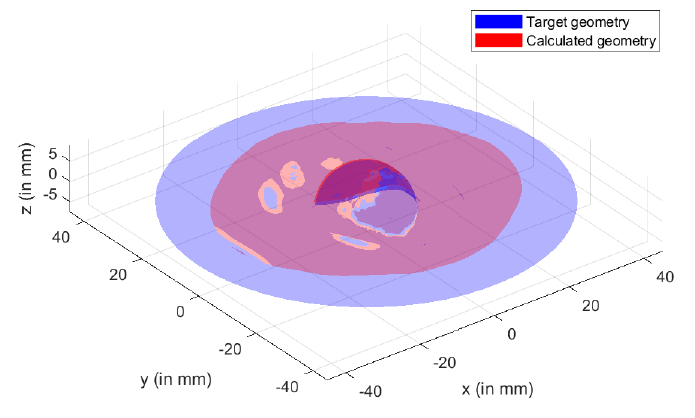
Figure 23. 3D Comparison between target and simulated geometry of hip cup